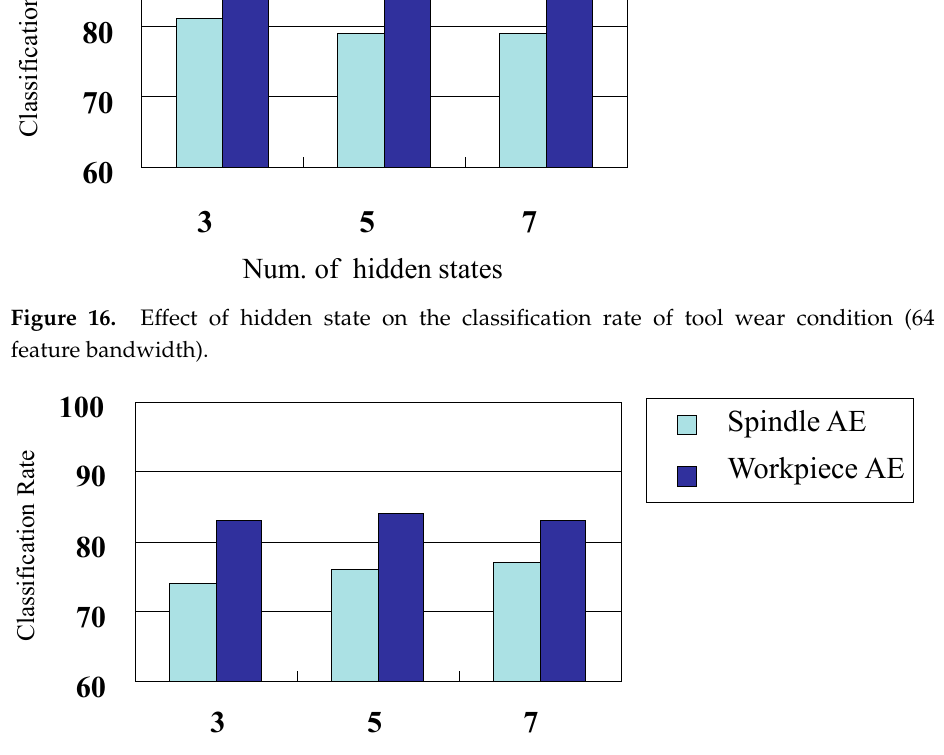
Figure 17. Effect of hidden state on the classification rate of tool wear condition (32 KHz feature bandwidth).